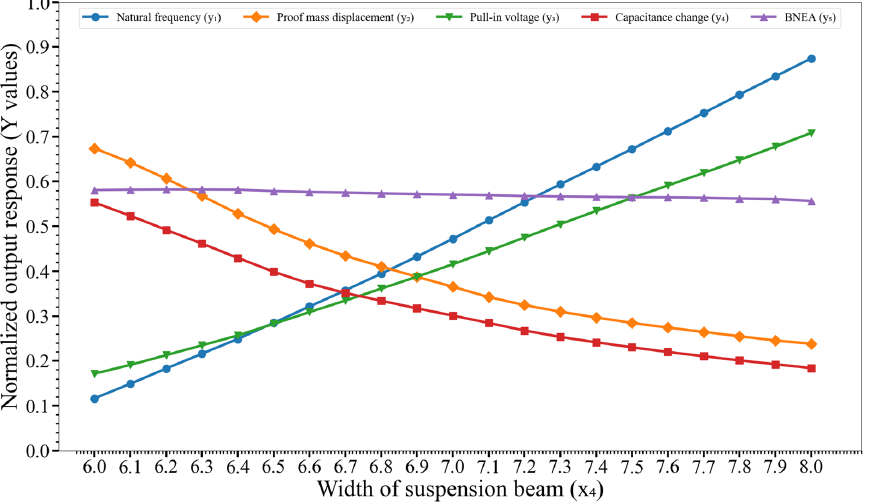
Figure 10. E ff ect of variation of the width of the suspension beam (x 4 ) on the output responses y 1 ,